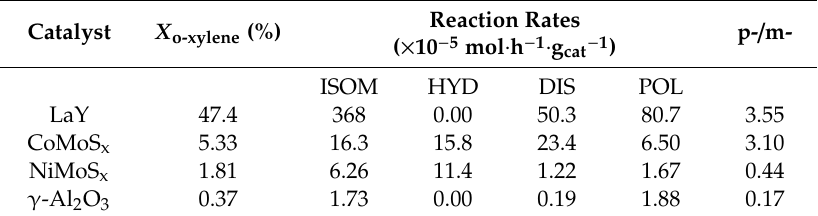
Table 2. Catalytic activity data at 24 h of t.o.s.